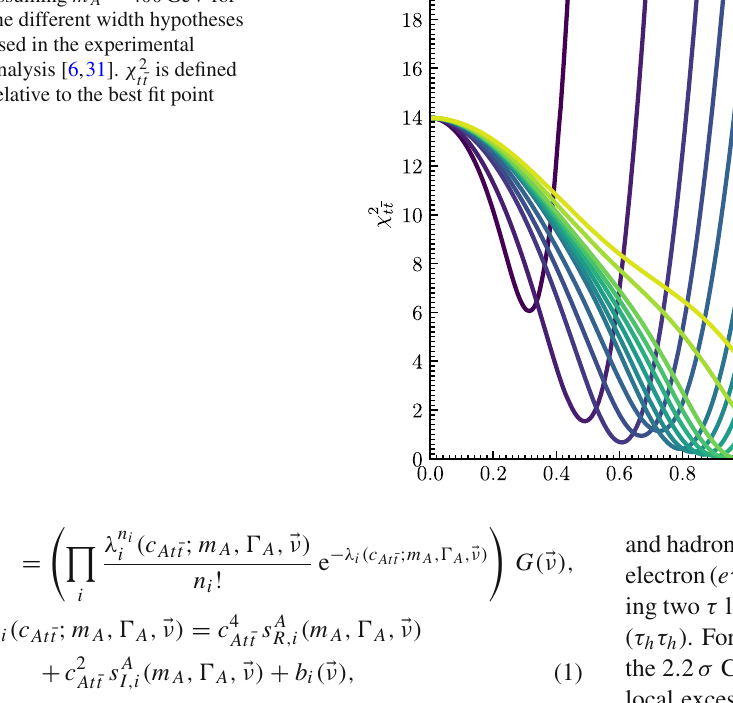
Fig. 1 χ 2 as a function of c At ¯ t t ¯ t assuming m A = 400GeV for the different width hypotheses used in the experimental analysis [6,31]. χ 2 is defined t ¯ t relative to the best fit